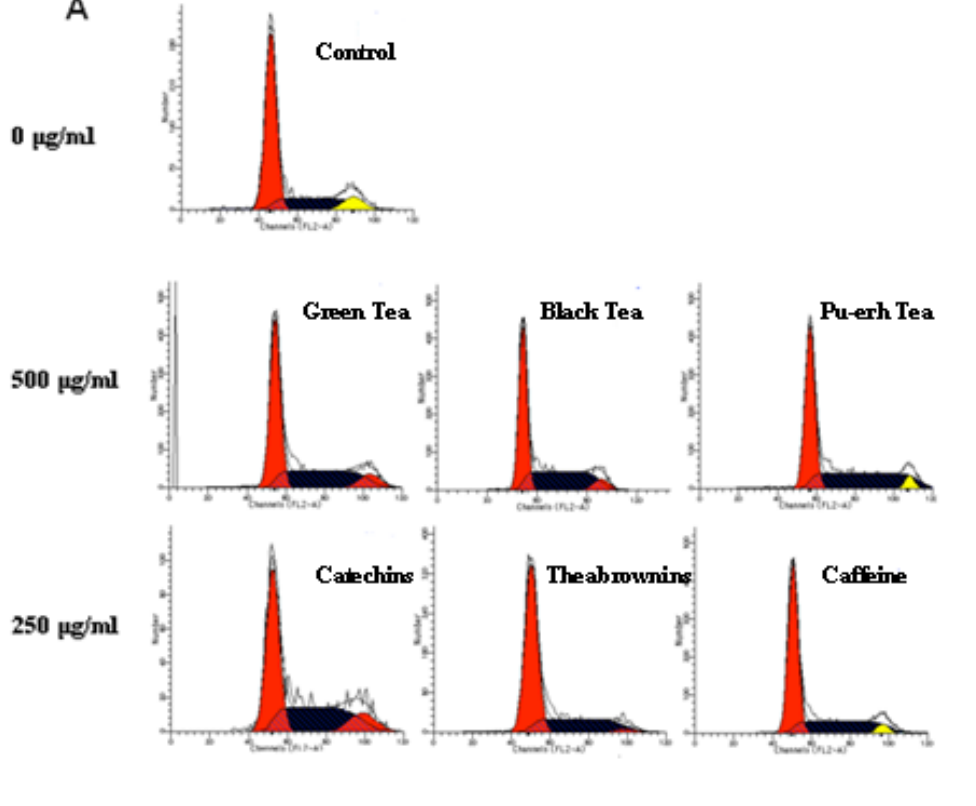
Figure 4. Cell cycle analysis of SGC-7901 and CCC-HEL-1 cells after treatment with three kinds of tea extract and their main constituents. ( A ) Cell cycle phase distributions of SGC-7901 cells cultured under three same concentrations with apoptosis analysis, and the high concentration of each tea extract and the constituents were shown; ( B ) The data with various concentration treatments in SGC-7901 cells was calculated and expressed by histogram; ( C ) Cell cycle phase distributions of CCC-HEL-1 cells cultured under the same concentration with apoptosis, and the data was calculated and expressed by